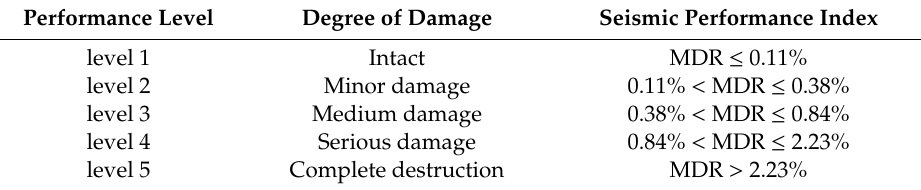
Table 3. Division of each damage state to the wall pier in out of